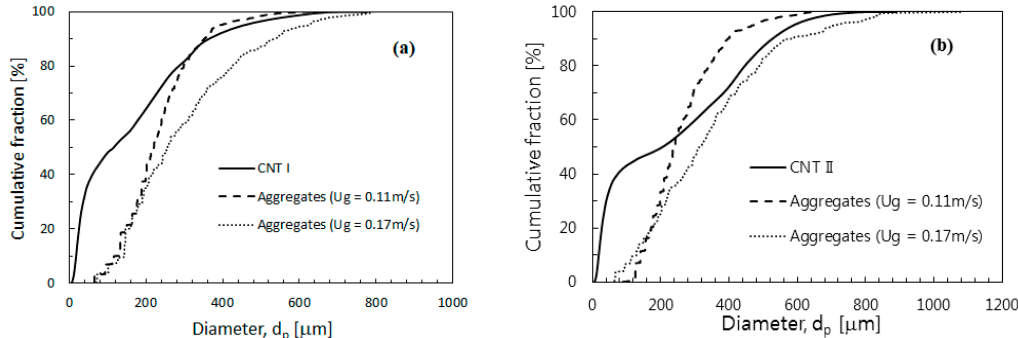
Figure 7. Variation of CNT particle/aggregates diameter distributions with gas velocity. ( a ) CNT I, ( b ) CNT II.